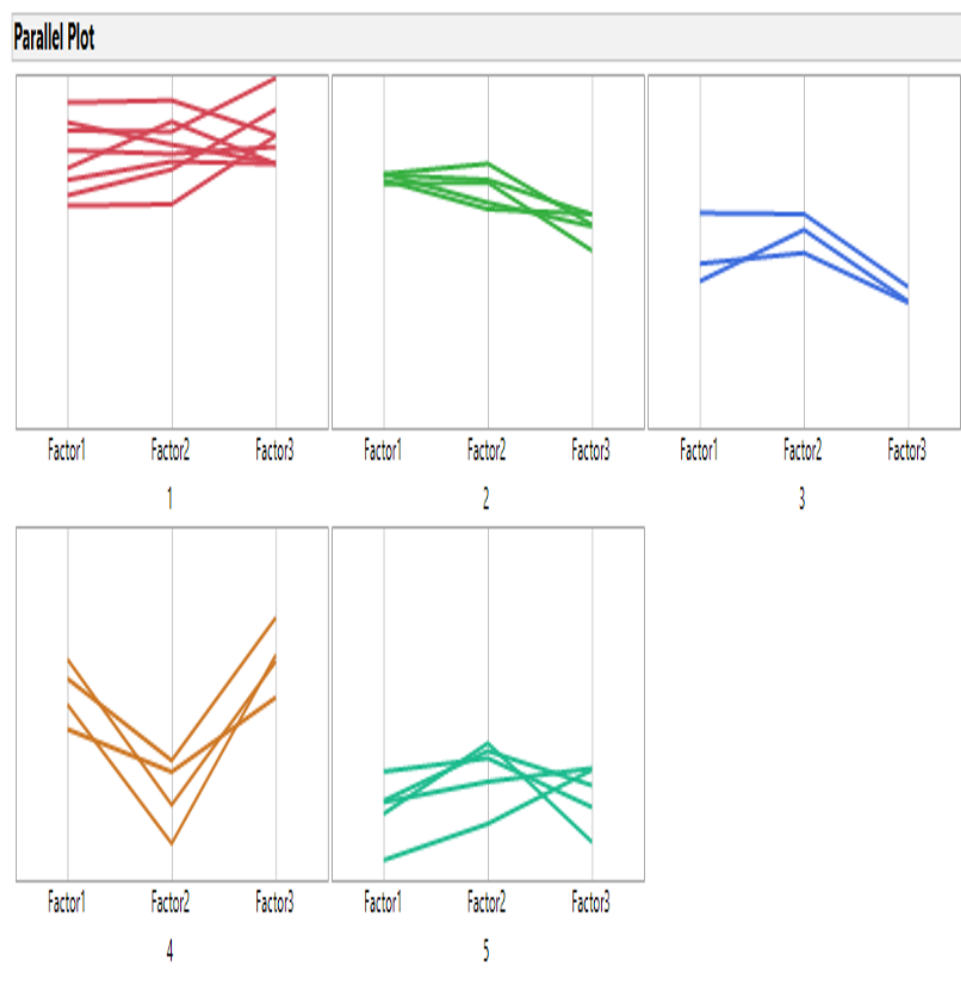
Figure 6. Parallel plots of the European countries clusters according to extracted factors Source: self-processed in SAS